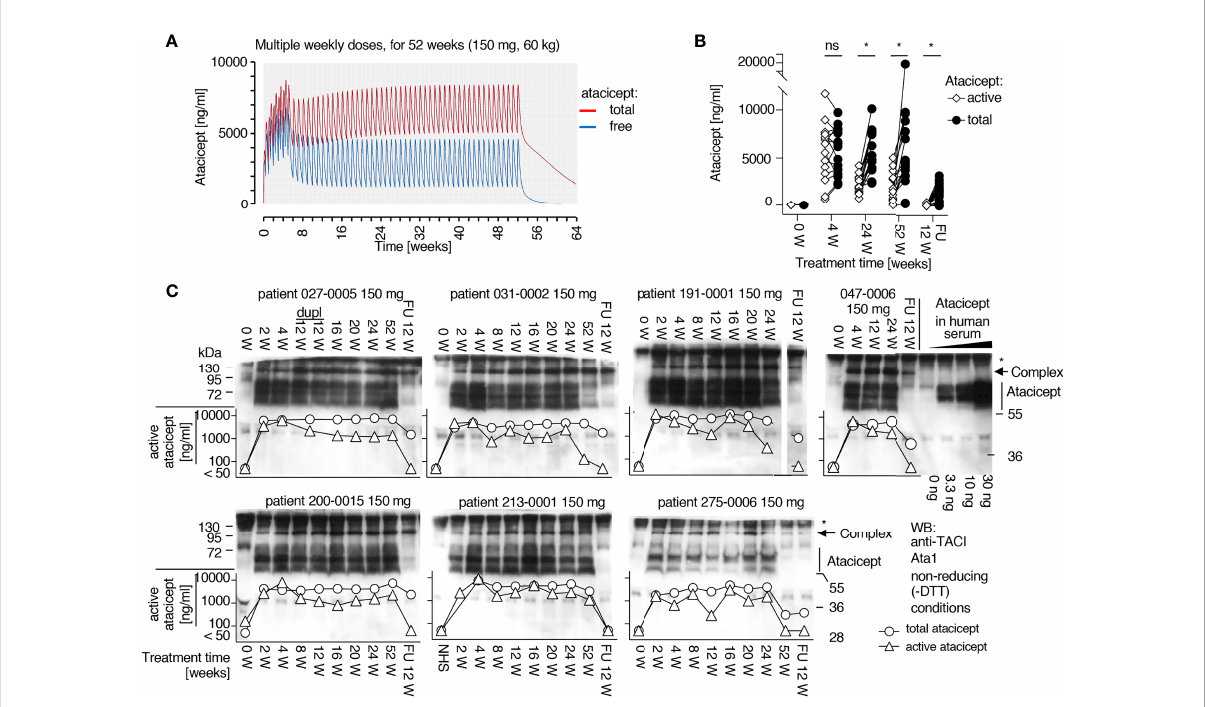
FIGURE 4 Prediction of free atacicept and measure of active atacicept in SLE patients receiving multiple injections of atacicept. (A) Population PK model for a 60 kg subject receiving 150 mg atacicept twice a week for 4 weeks, then weekly for 48 more weeks, with blue and red lines indicating predicted levels of free and total atacicept, respectively. (B) Active and total atacicept in 15 SLE patients (10 x 150 mg, 5 x 75 mg), before treatment, at weeks 4, 24 and 52 of treatment, and 12 weeks after treatment end (FU 12 W). Two ways ANOVA with Sida ́ k ’ s multiple comparison test was used to compare active versus total atacicept at each time point. ns, not signi fi cant. *p < 0.05. Experiment performed once. (C) Active atacicept measured pre-dose, at the indicated time points during a 1-year atacicept treatment with bi-weekly administration of 150 mg atacicept for 4 weeks, then weekly for 48 further weeks, and at follow-up 12 weeks after treatment end (FU 12 W), in seven SLE patients. Serum samples (1 µl) collected at trough were analyzed in parallel by denaturing, but non-reducing SDS-PAGE followed by Western blot with anti-TACI mAb Ata1. cplx: atacicept-containing complex. ata: atacicept. NHS, normal human serum. Experiment was performed once in this format, and twice with reduced numbers of patients and time